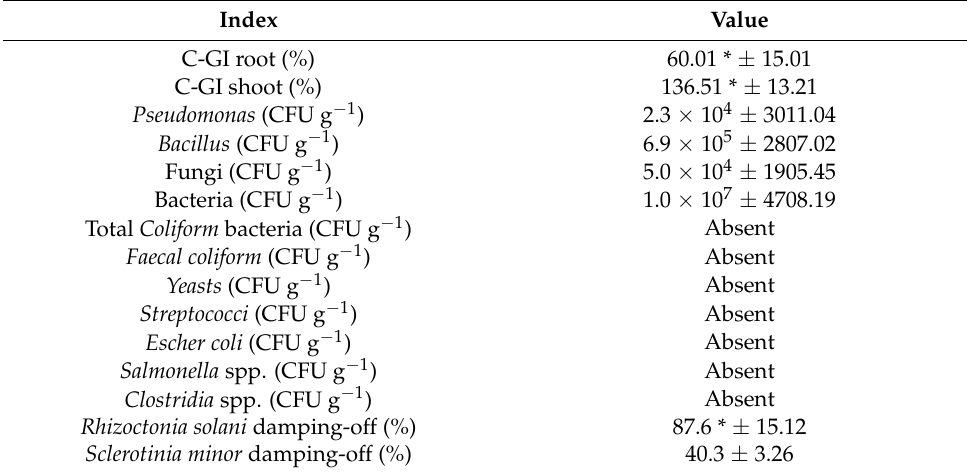
Table 2. Phytotoxicity assessment and microbiological and suppressiveness characterization of Compost. * = statistically significant; CFU = colony forming unit. Data are reported as mean values ( n = 5) ±